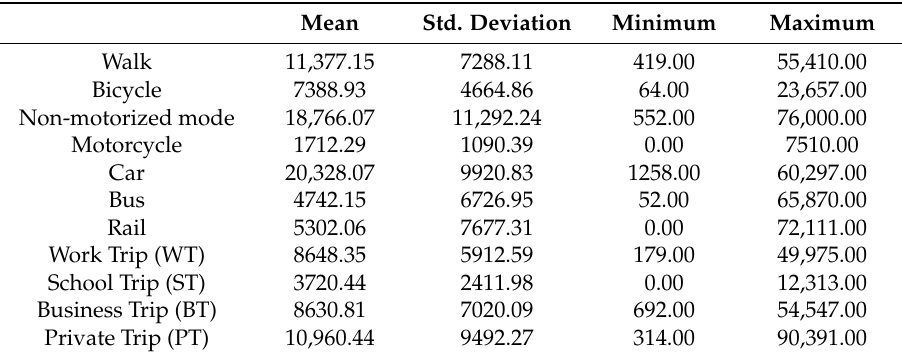
Table 3. Descriptive result summary—travel